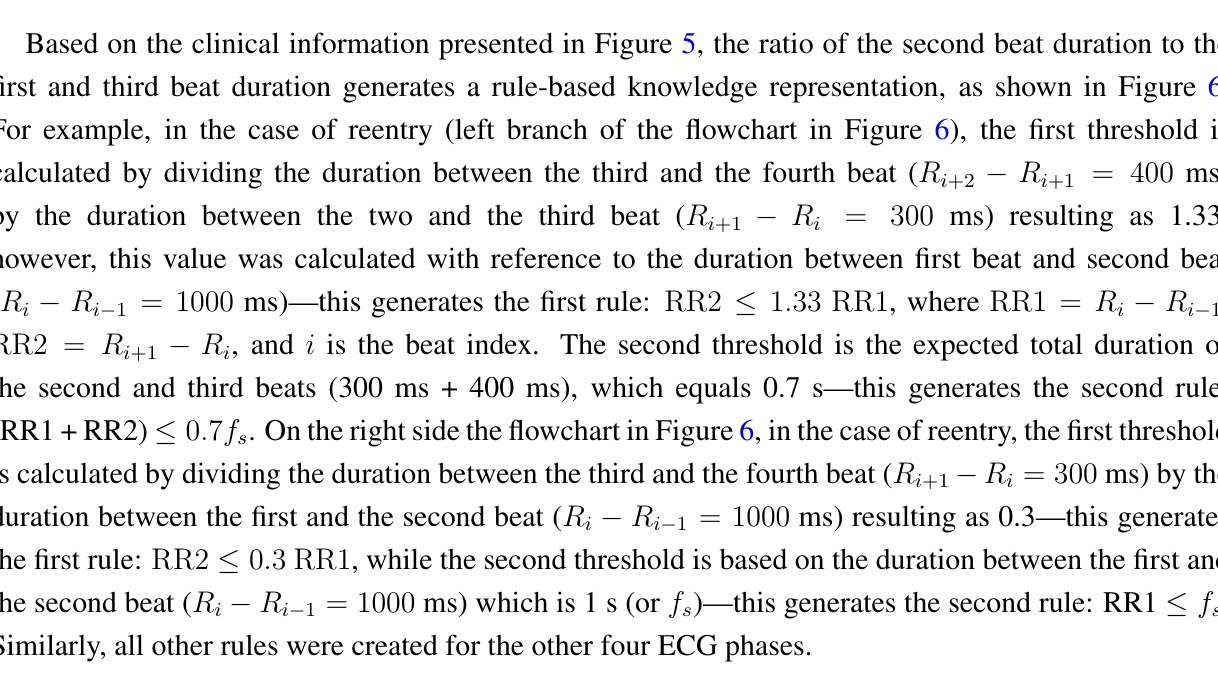
Figure 5. Types of sinus node response to atrial premature depolarization (adapted from